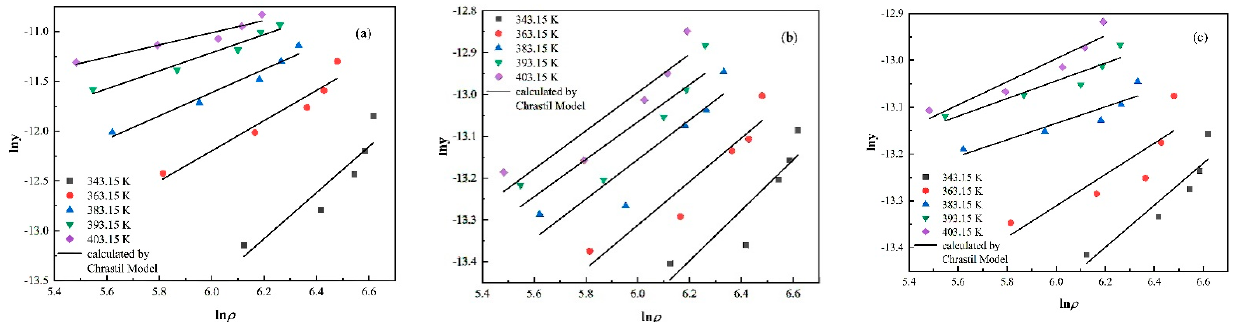
Figure 2. Solubilities in sc − CO 2 calculated by the Chrastil model for ( a ) DR 73, ( b ) DR 19, ( c ) DR DO S-RL.